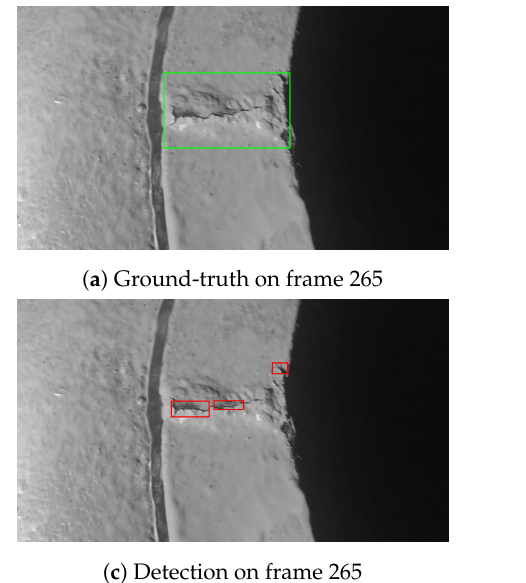
Figure 7. Object detection model occasionally predicted several small bounding boxes partly locating the crack.